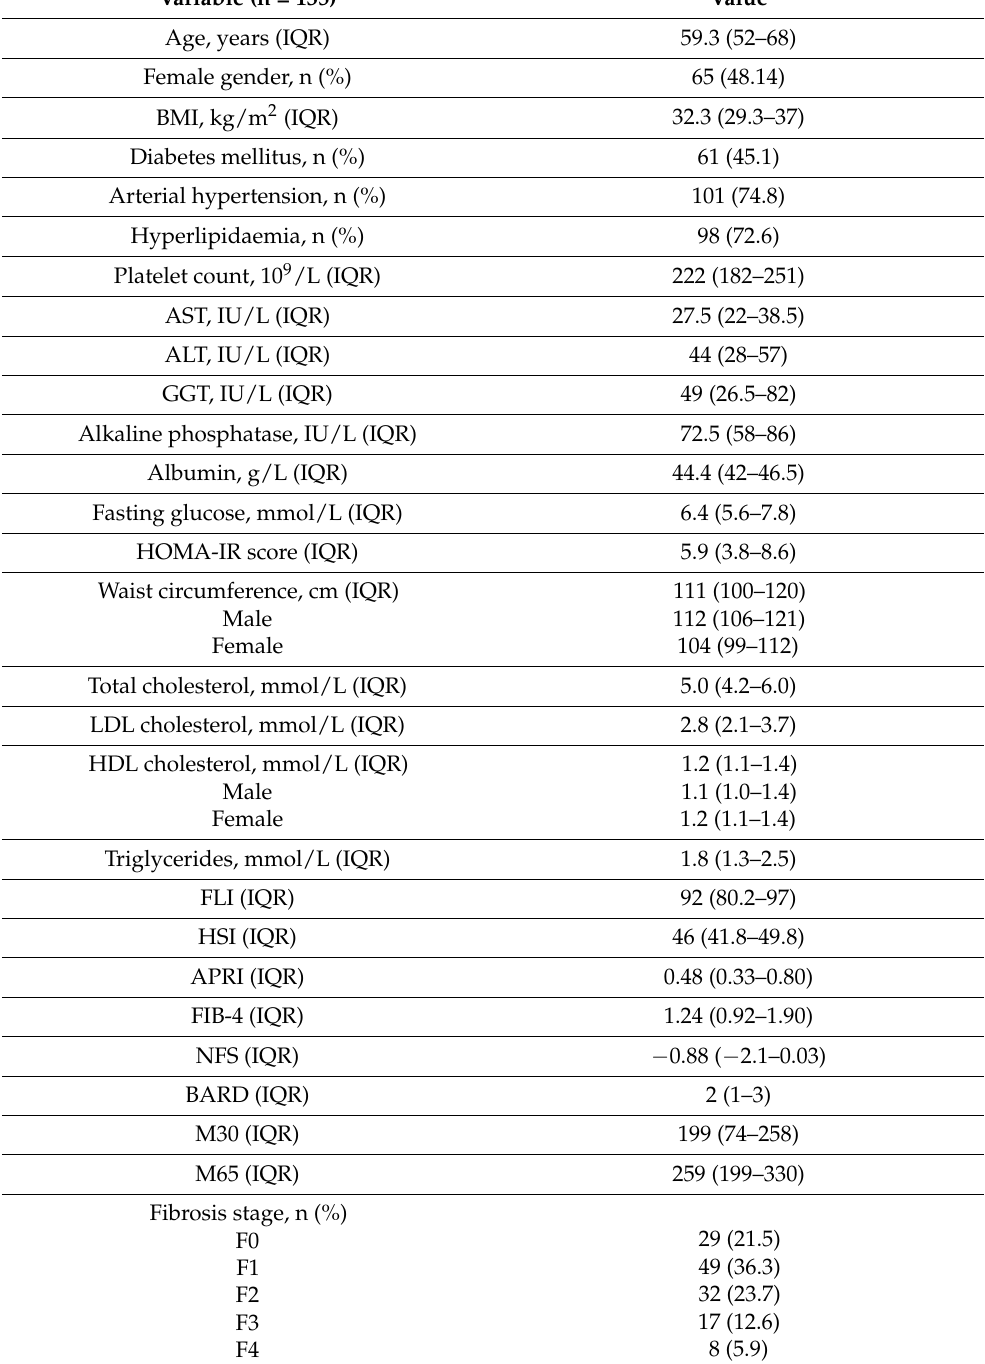
Table 1. General characteristics of the analysed cohort of 135 NAFLD